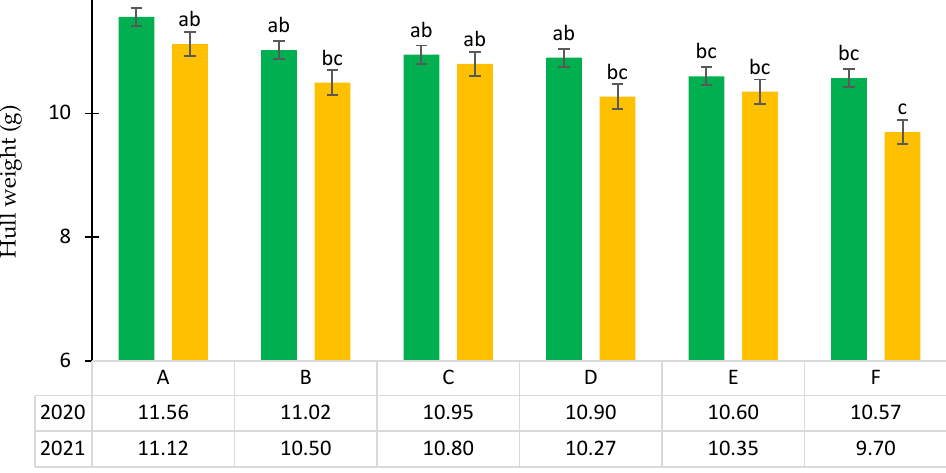
Figure 5. Hull weight (g). A–F—variants of fertilization. Different lowercase letters indicate signifi- cant differences ( p < 0.05) according to the analysis of variance (ANOVA).